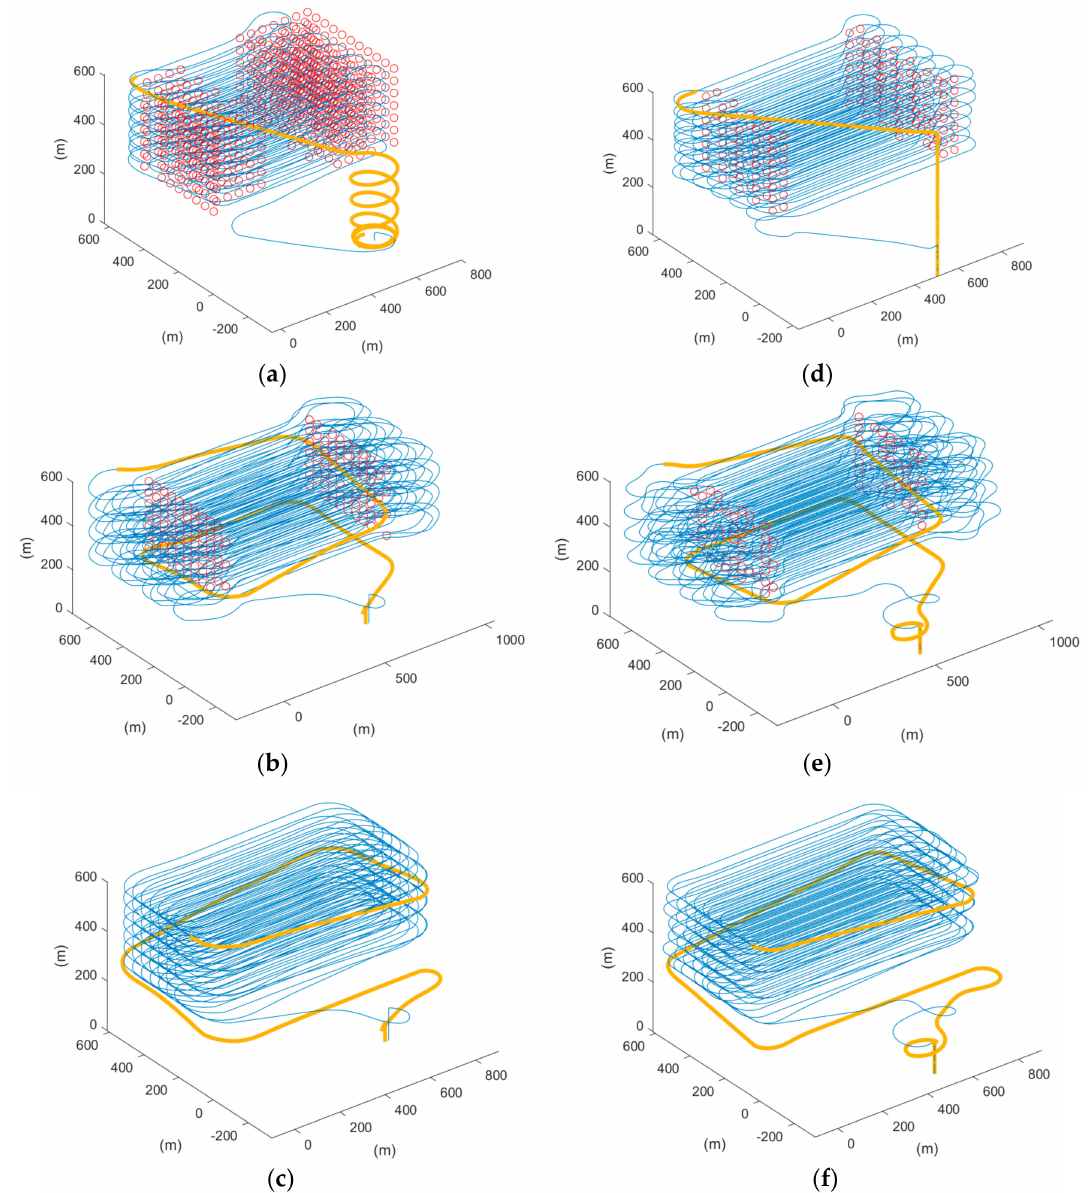
Figure 20. The 3D trajectory results of scenario 1 in blue lines, the not approached sampling points in red circles, and returning route in orange bold lines of ( a ) auto-grid paths, ( b ) cycle-Boustrophedon, and ( c ) circling-forward in simulation platform 1, and ( d ) auto-grid paths, ( e ) cycle-Boustrophedon, and ( f ) circling-forward in simulation platform